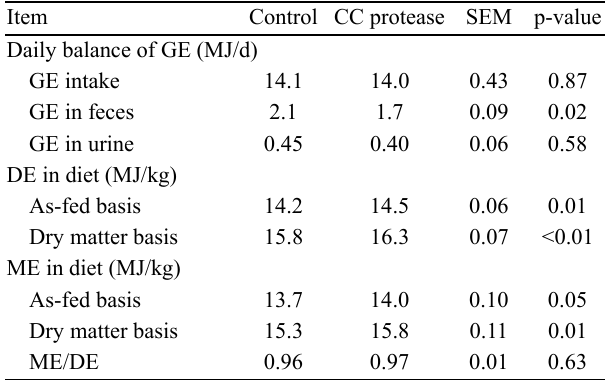
Table 2. Daily balance of gross energy (GE) and concentration of digestible and metabolizable energy (DE and ME) in basal diet or diet with 0.2 g/kg proteases for pigs (Exp. 1)